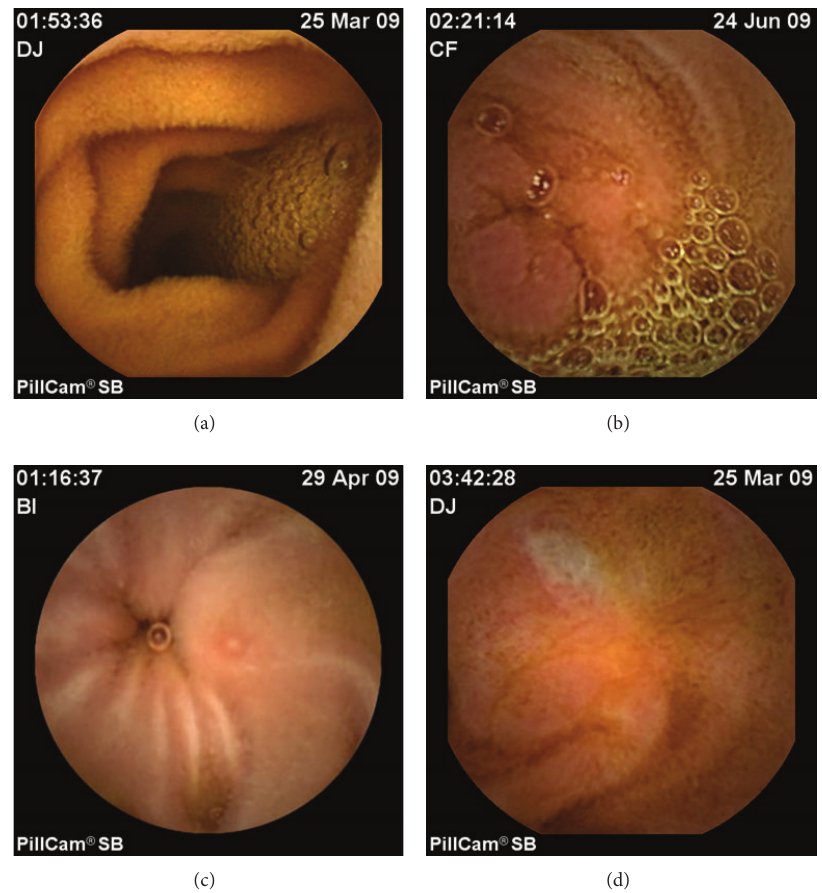
Figure 2: Small bowel lesions of GI-GVHD detected by wireless capsule endoscopy (WCE). (a) Normal jejunum, (b) focal edema and enanthematous aspect of the jejunum, (c) aphtoid erosion in the proximal ileum, and (d) large superficial ulceration of the